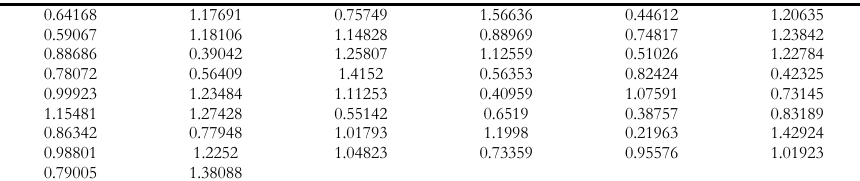
Simulated data from Weibull model with